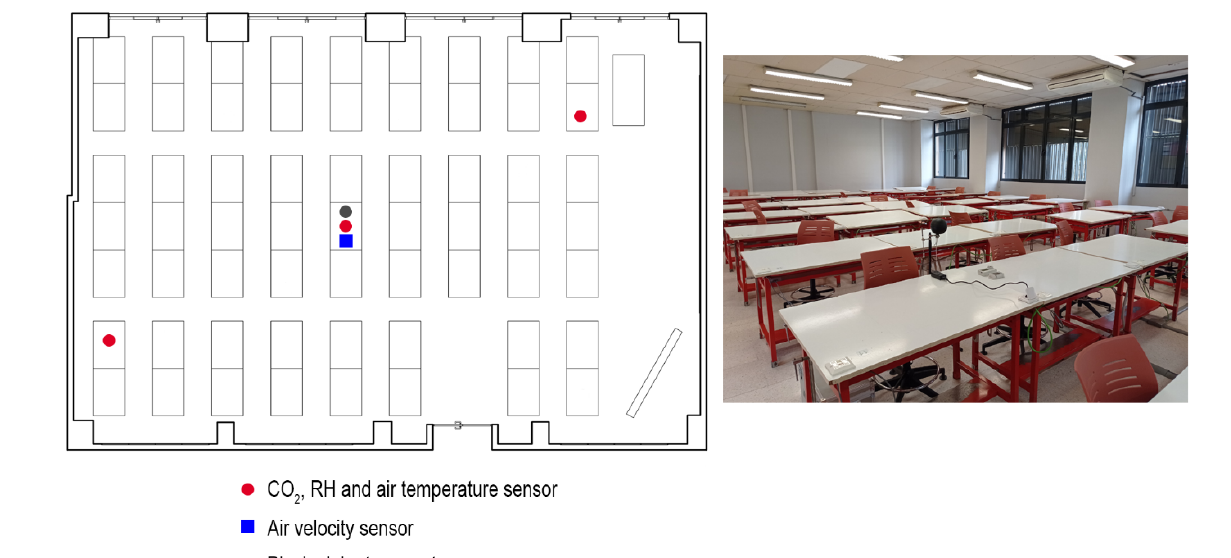
Table 3. Scales used in the questionnaire survey.